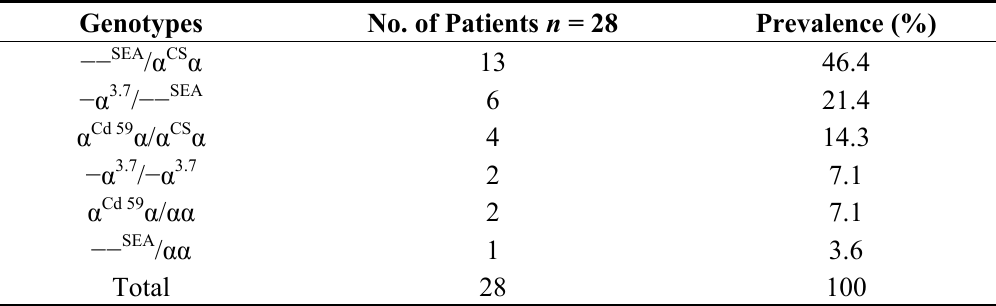
Table 2. Prevalence of α -thalassaemia genotypes in Malay patients.